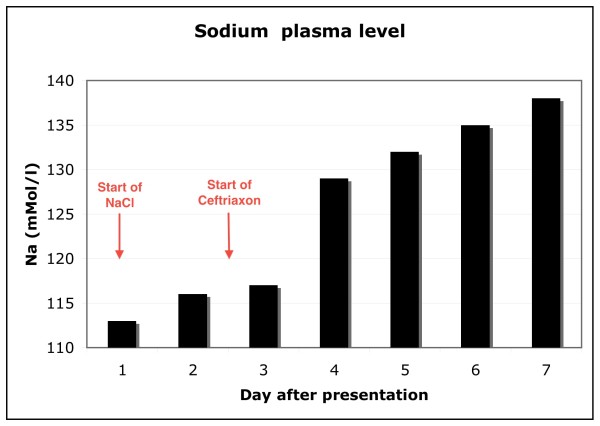
Plasma sodium concentration. On the day of presentation oral sodium chloride substitution and water restriction were started. Sodium concentration normalized rapidly after the start of ceftriaxone treatment while sodium chloride substitution was not increased.